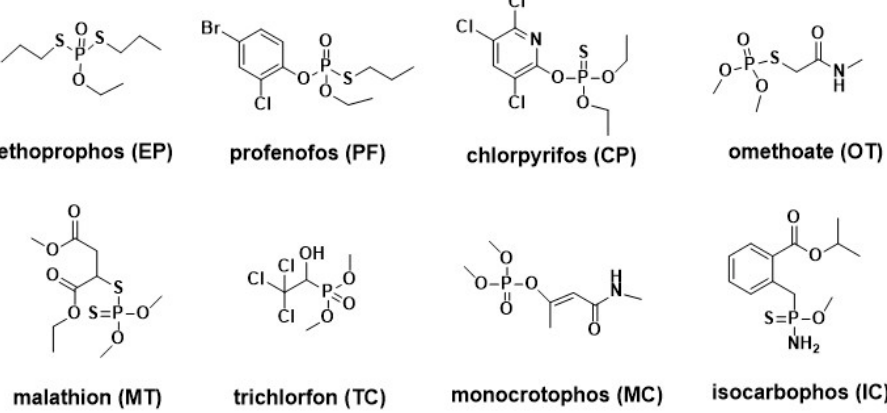
Figure 1. The structure of organophosphate (OP) pesticides.